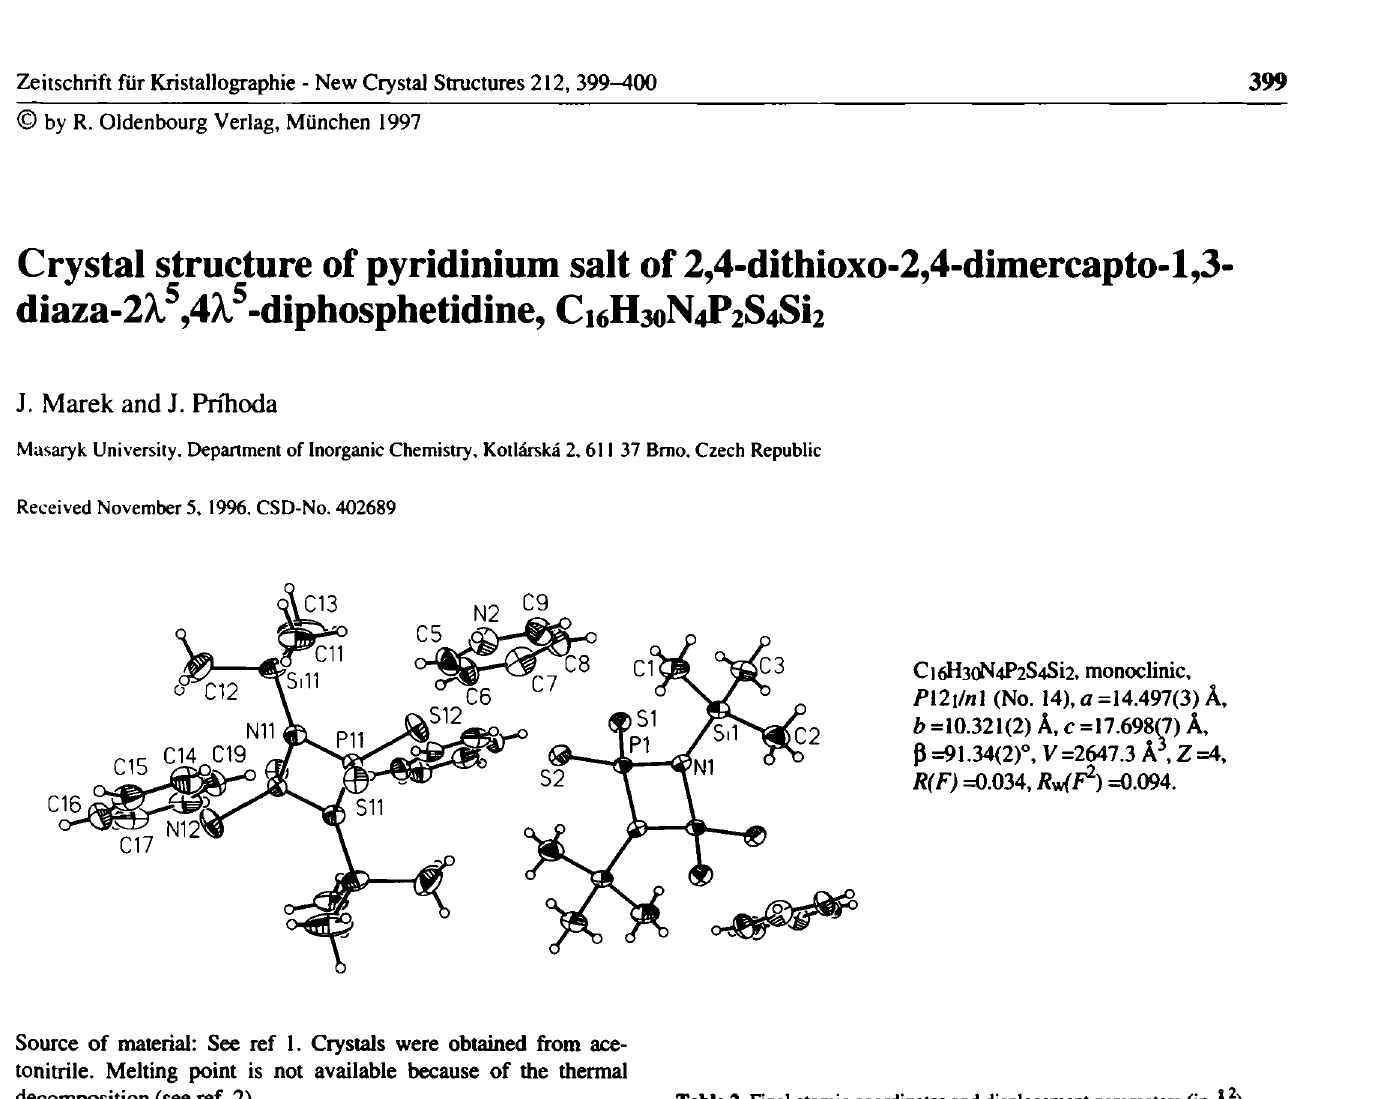
Table 2. Final atomic coordinates and displacement parameters (in Â 2